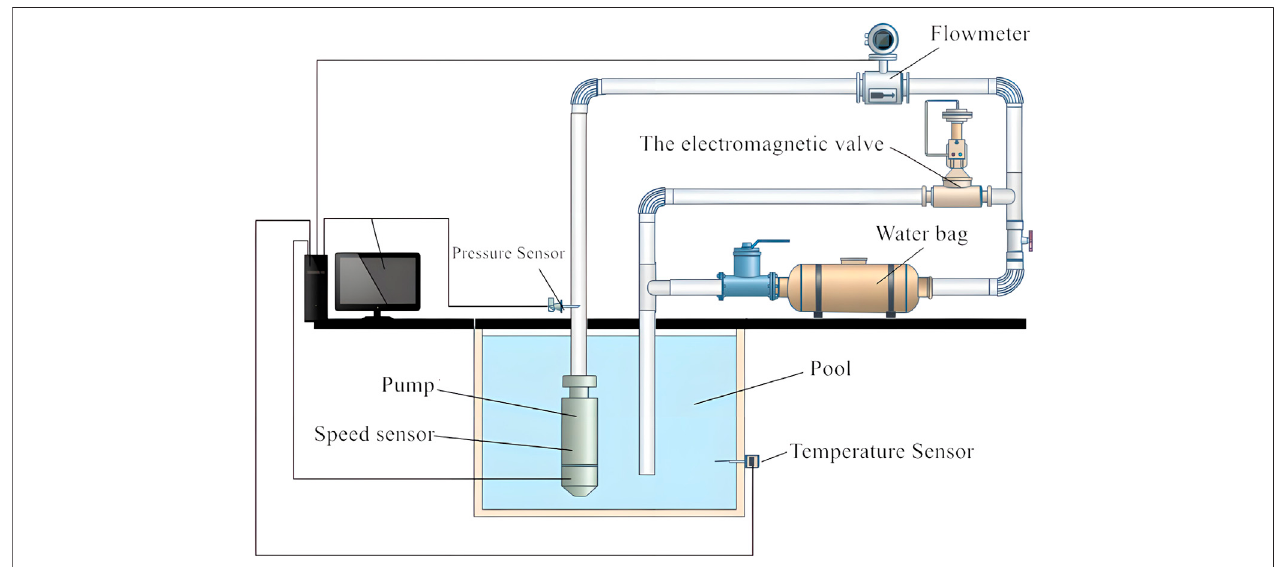
FIGURE 9 | Schematic of the test